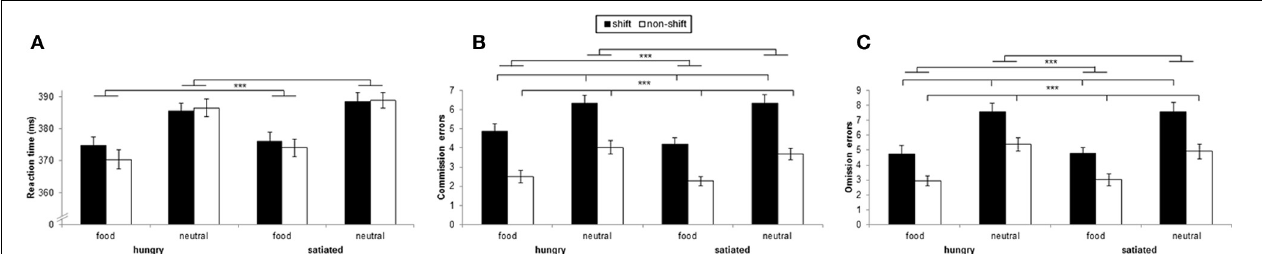
FIGURE 6 | Task performance as a function of target type, block type, and group in study 2. Displayed is (A) reaction time in go-trials in ms, (B) number of commission, and (C) omission errors. Error bars indicate standard errors of the mean. ∗∗∗ p < 0 .